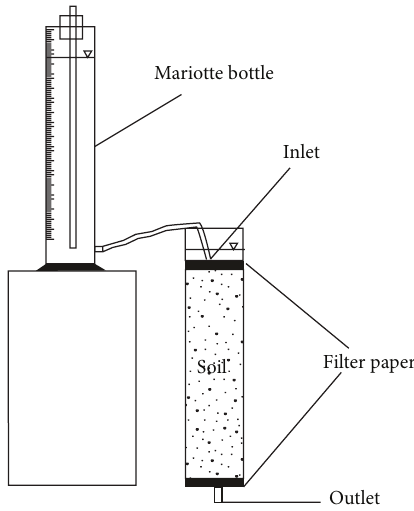
Figure 2: Schematic diagram of the infiltration experiment setup.